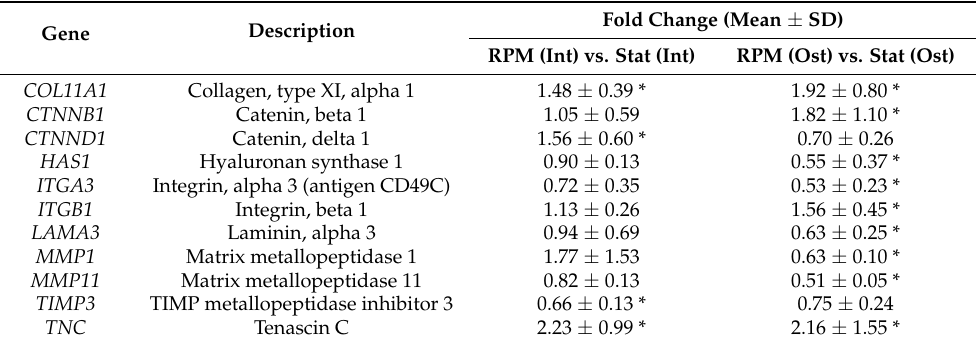
Table 1. Relative expression of matrix/adhesion associated genes after 10 days of RPM exposure of intact (Int) and osteocommitted (Ost) MSCs. Fold Change (Mean ± SD) Gene Description RPM (Int) vs. Stat (Int) RPM (Ost) vs. Stat (Ost) COL11A1 Collagen, type XI, alpha